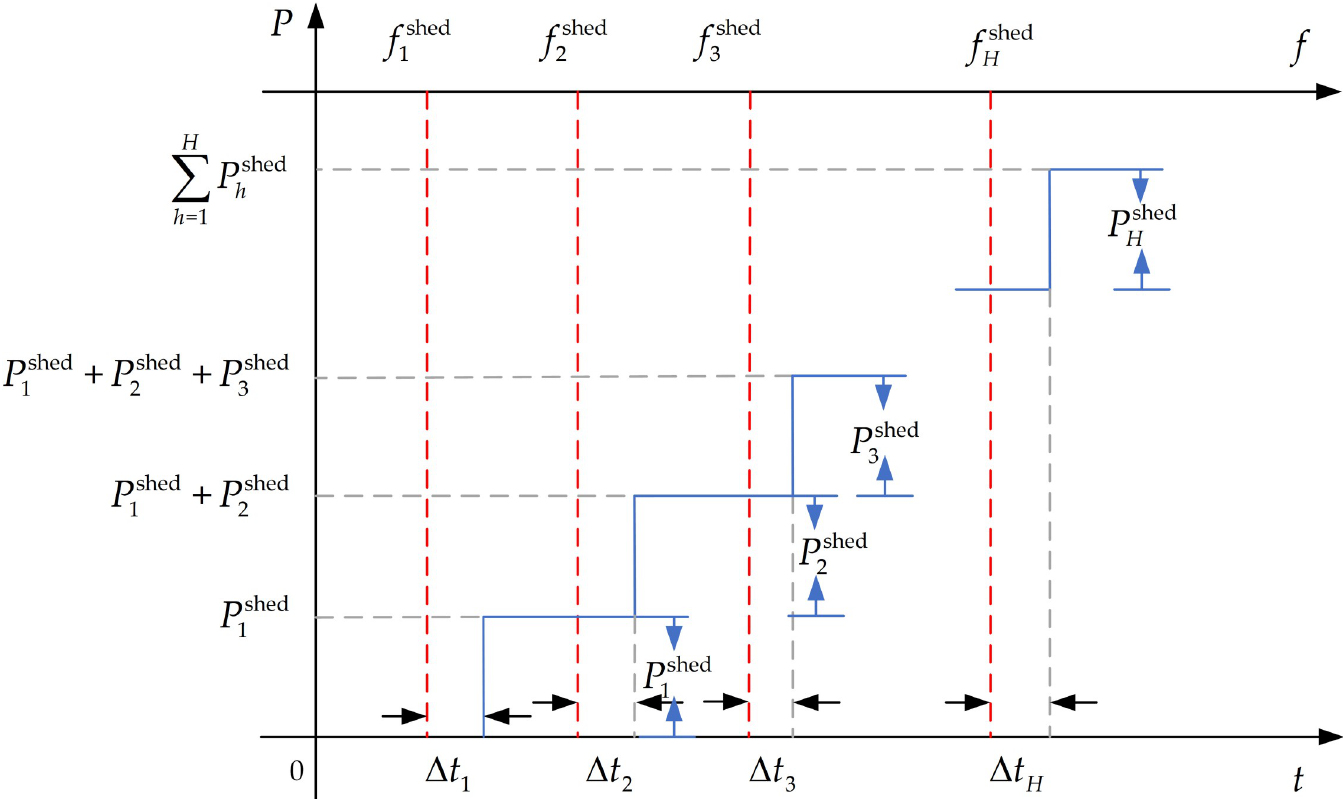
Fig 3. Principle of the under-frequency load